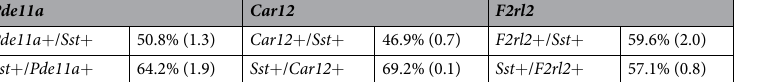
Table 2. Quantification of Gene Co-Expression by In Situ Hybridization. For Car12, Pde11a and F2rl2 , the percentage co-expression with Sst is indicated. Standard error of the mean is in parentheses. n =